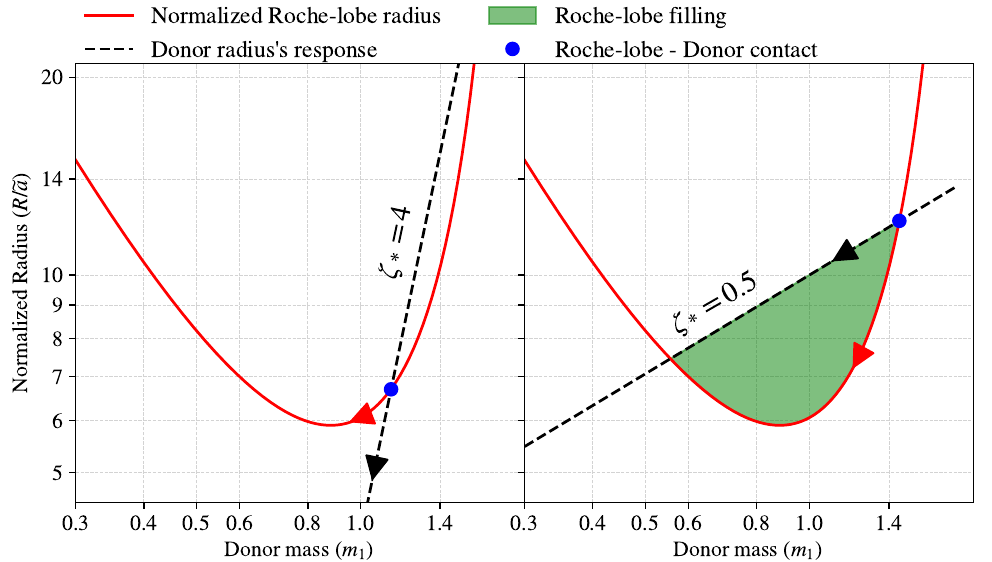
figure. As soon as mass transfer initiates, the star contracts significantly more (black arrow) than R L does (red arrow), i.e., ζ L < ζ ∗ . Thus, the star remains in thermal equilibrium, and mass transfer stops until nuclear reactions cause a further expansion of the donor. This is a typical case of (nuclear) stable mass transfer. In the right panel, a star with a shallower response ( ζ ∗ = 0.5) and m 1 (cid:39) 1.5 is considered. In this case, R L shrinks more than R ∗ (i.e., ζ L > ζ ∗ ), therefore increasing the Roche-lobe filling factor and the mass loss rate. This is a typical case of the beginning of a thermally unstable mass transfer, for which ζ ∗ = ζ th . By looking at the right panel of Figure 6, this configuration might last until m 1 (cid:39) 0.55 M (cid:12) , though, depending on the R L -filling factor, mass loss can become fast enough to drive the donor out of dynamical equilibrium, so that ζ ∗ = ζ ad . For typical giant stars, mass loss easily evolves towards a very high rate. This happens because ζ ad (cid:39) − 0.3 (e.g., [35]), thus, such donors easily initiate a runaway R L -filling process that likely leads to CE evolution.